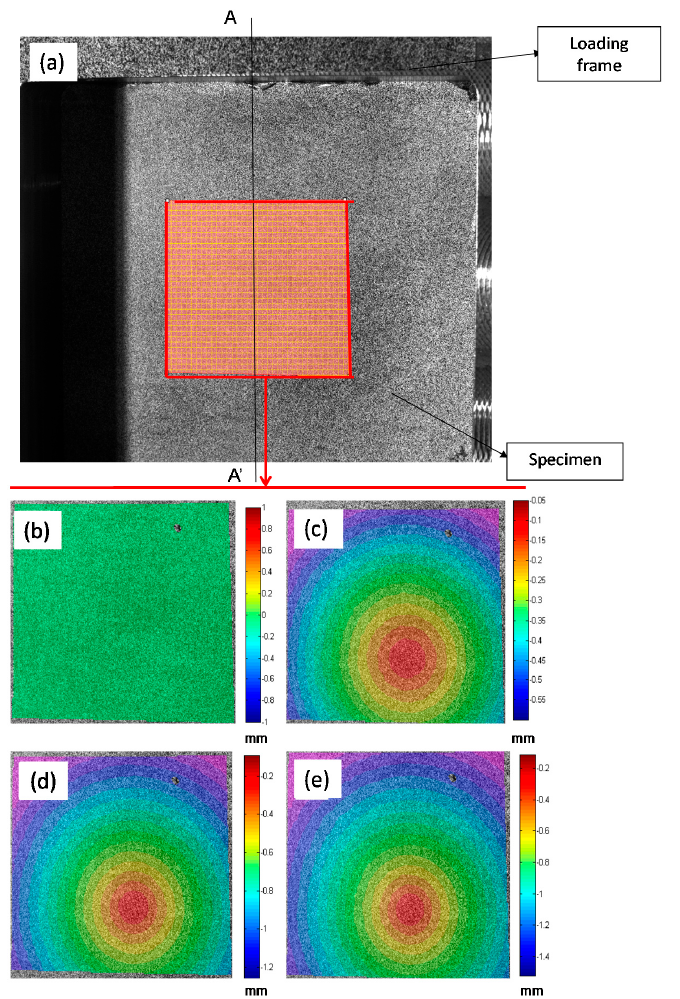
Figure 10. Region of interest for contact analysis. ( a ) Specimen image before starting a quasi-static test. Out of plane displacements measured in a 2 mm-thick specimen at the region of interest for different loads; ( b ) 0 mm to 0 N; ( c ) − 0.05 mm to 320 N; ( d ) − 0.096 mm to 611 N; ( e ) − 0.111 mm to 731 N.